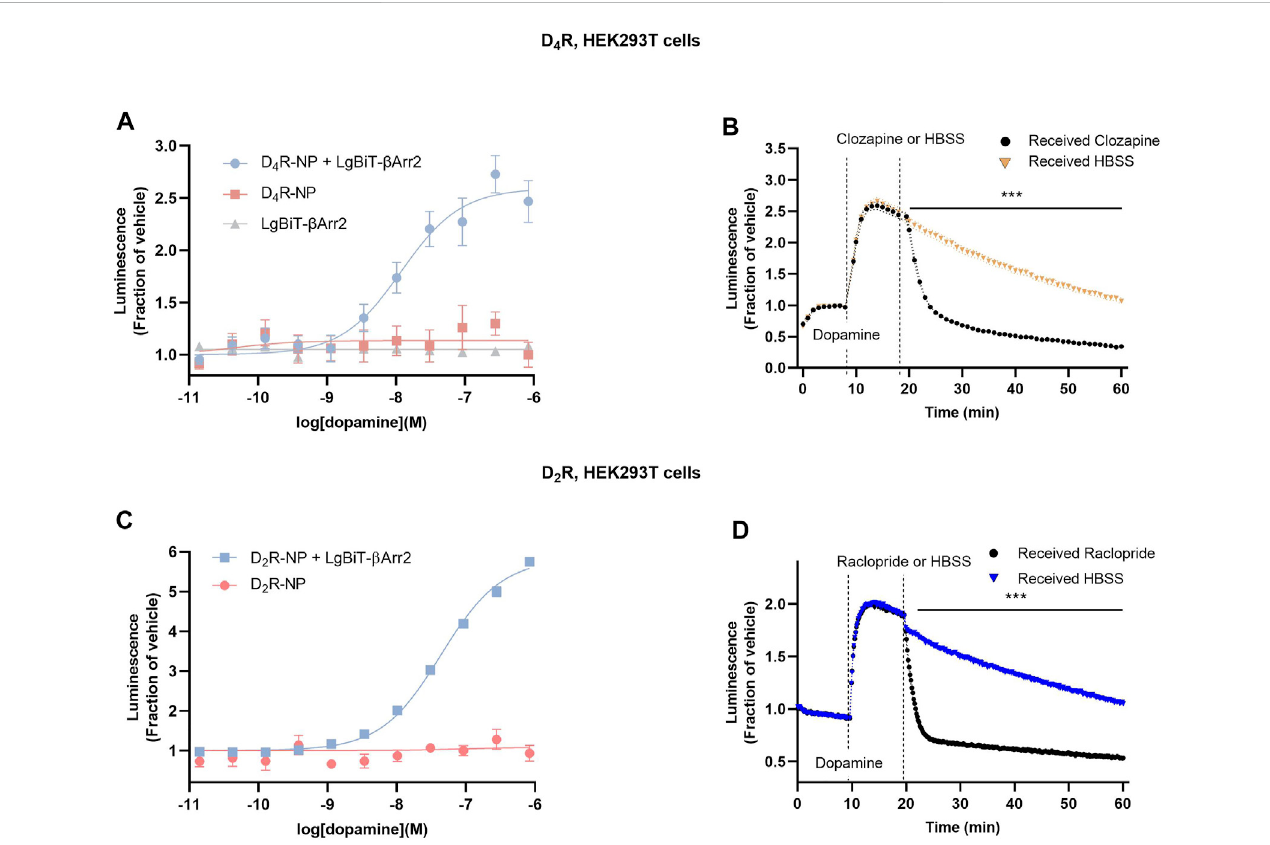
FIGURE 1 Arrestin recruitment to the D 4 R as measured by a modi fi ed NanoBiT complementation bioluminescence assay. (A) A dopamine concentration- dependent increase in luminescence was observed in cells co-transfected with D 4 R-NP and LgBiT- β arr2, but not with either construct alone. (B) Kinetic experiments revealed a blockade of the dopamine-induced luminescence increase upon application of the D 4 R antagonist clozapine. (C) Dopamine concentration-response curve for the increase in luminescence in cells co-transfected with D 2 R-NP and LgBiT- β arr2, or with negative control (D 2 R-NP expressed alone). (D) Kinetic experiments revealed a blockade of the dopamine-induced luminescence increase upon application of the D 2 R antagonist raclopride. Asterisks and horizontal bars indicate intervals of statistically signi fi cant differences between HBSS control conditions and clozapine or raclopride. ***; p < 0.001, repeated measures ANOVA with Sidak ’ s multiple comparisons test. Luminescence data are expressed as fractions of the signal observed in vehicle-treated wells (A, C) or prior to dopamine application (B, D) . Each data point in (A – D) represents mean ± SEM of eight replicate wells from